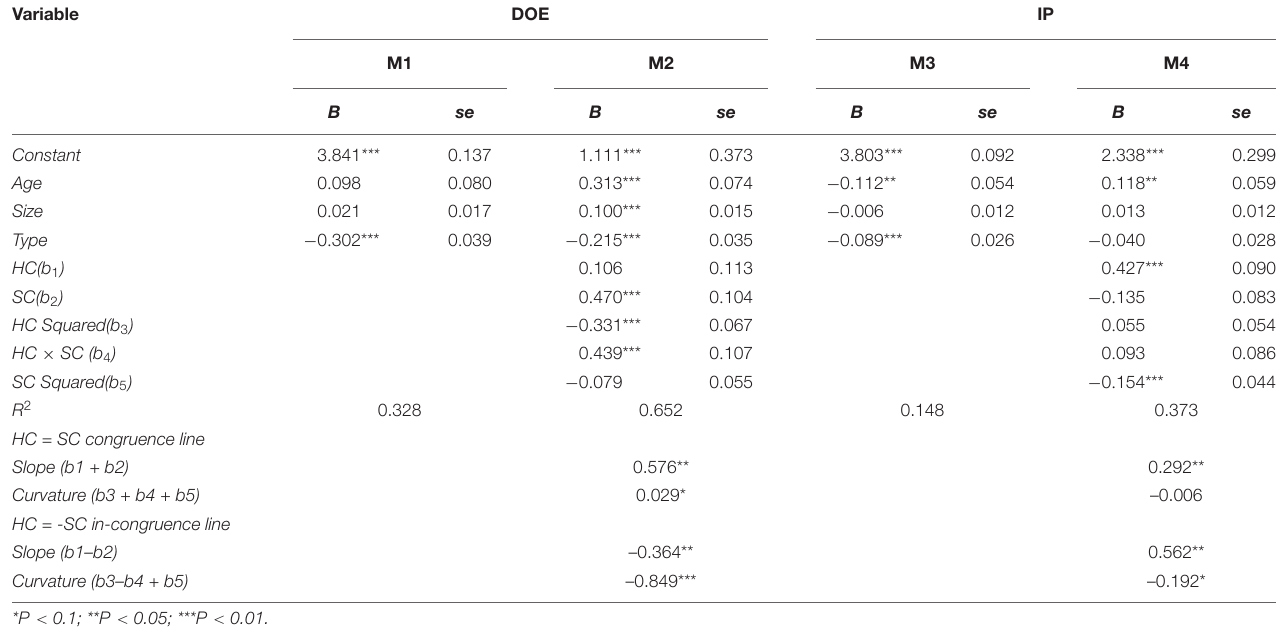
TABLE 3 | The results of polynomial regression. Variable